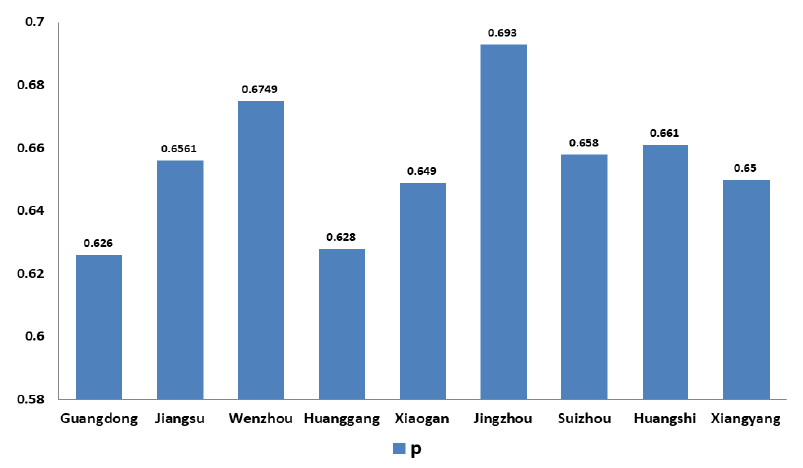
Figure 6. P -values of several cities (95% CI).